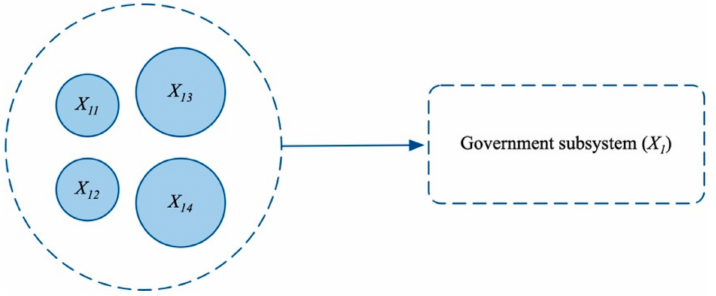
Figure 4. Indicators interaction in government